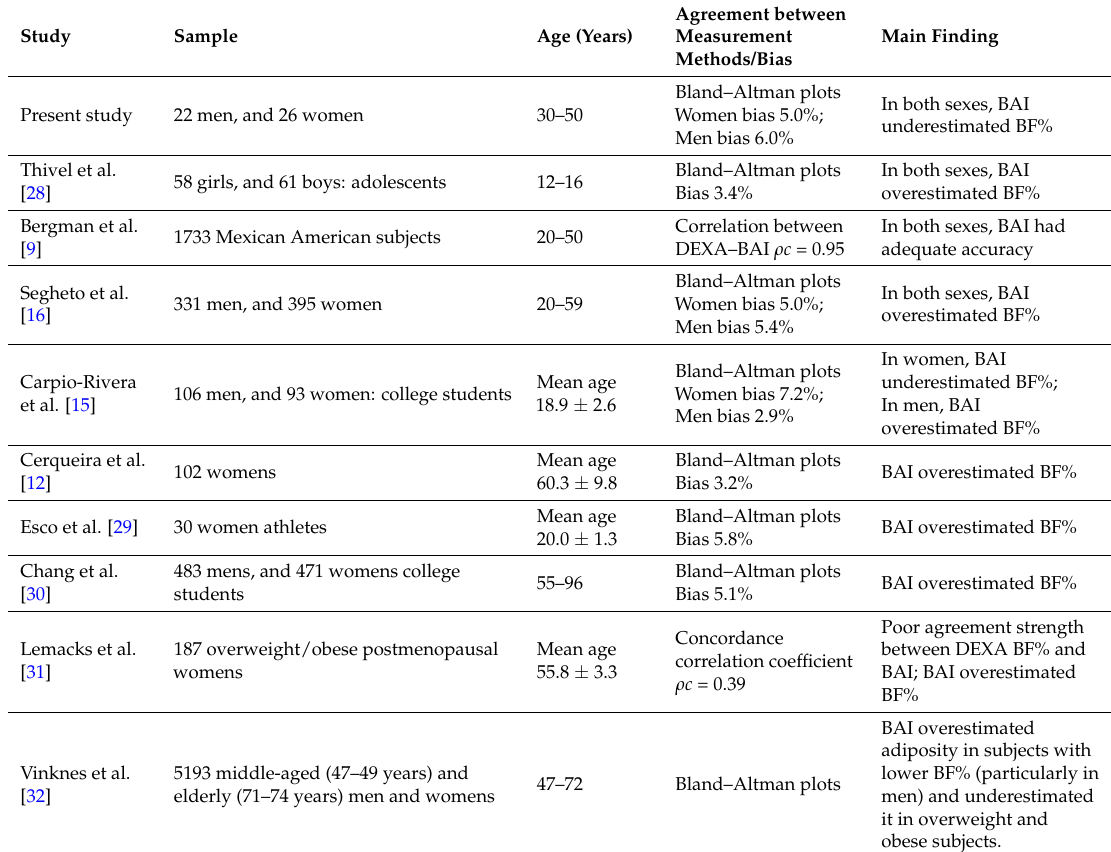
Table 4. Comparison of BAI parameters of the included trials